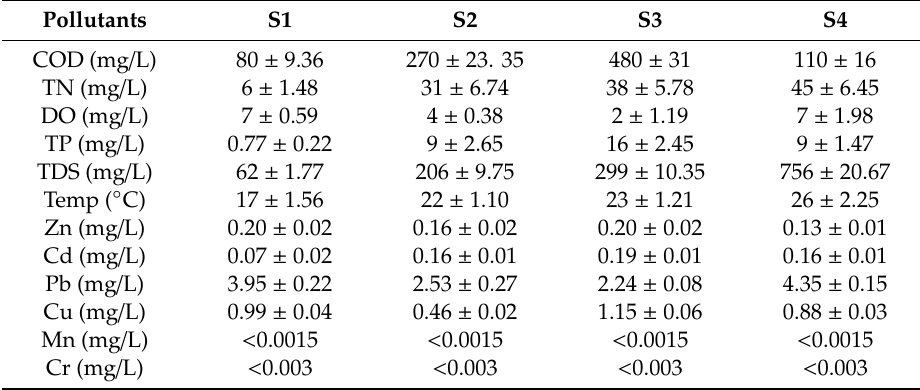
Table 1. Measurements of physicochemical parameters along the Apatlaco